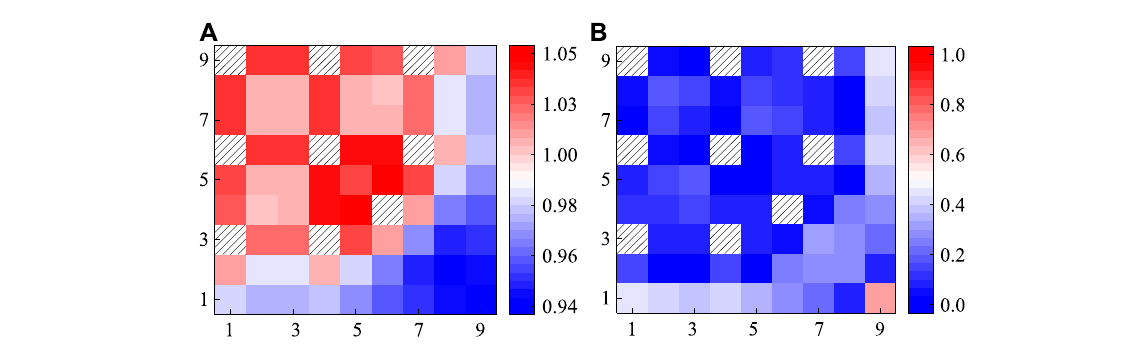
FIGURE 10 Calculation results of pin power of the VERA 2B lattice: (A) referenced normalized pin power; (B) absolute value of relative deviation/%.